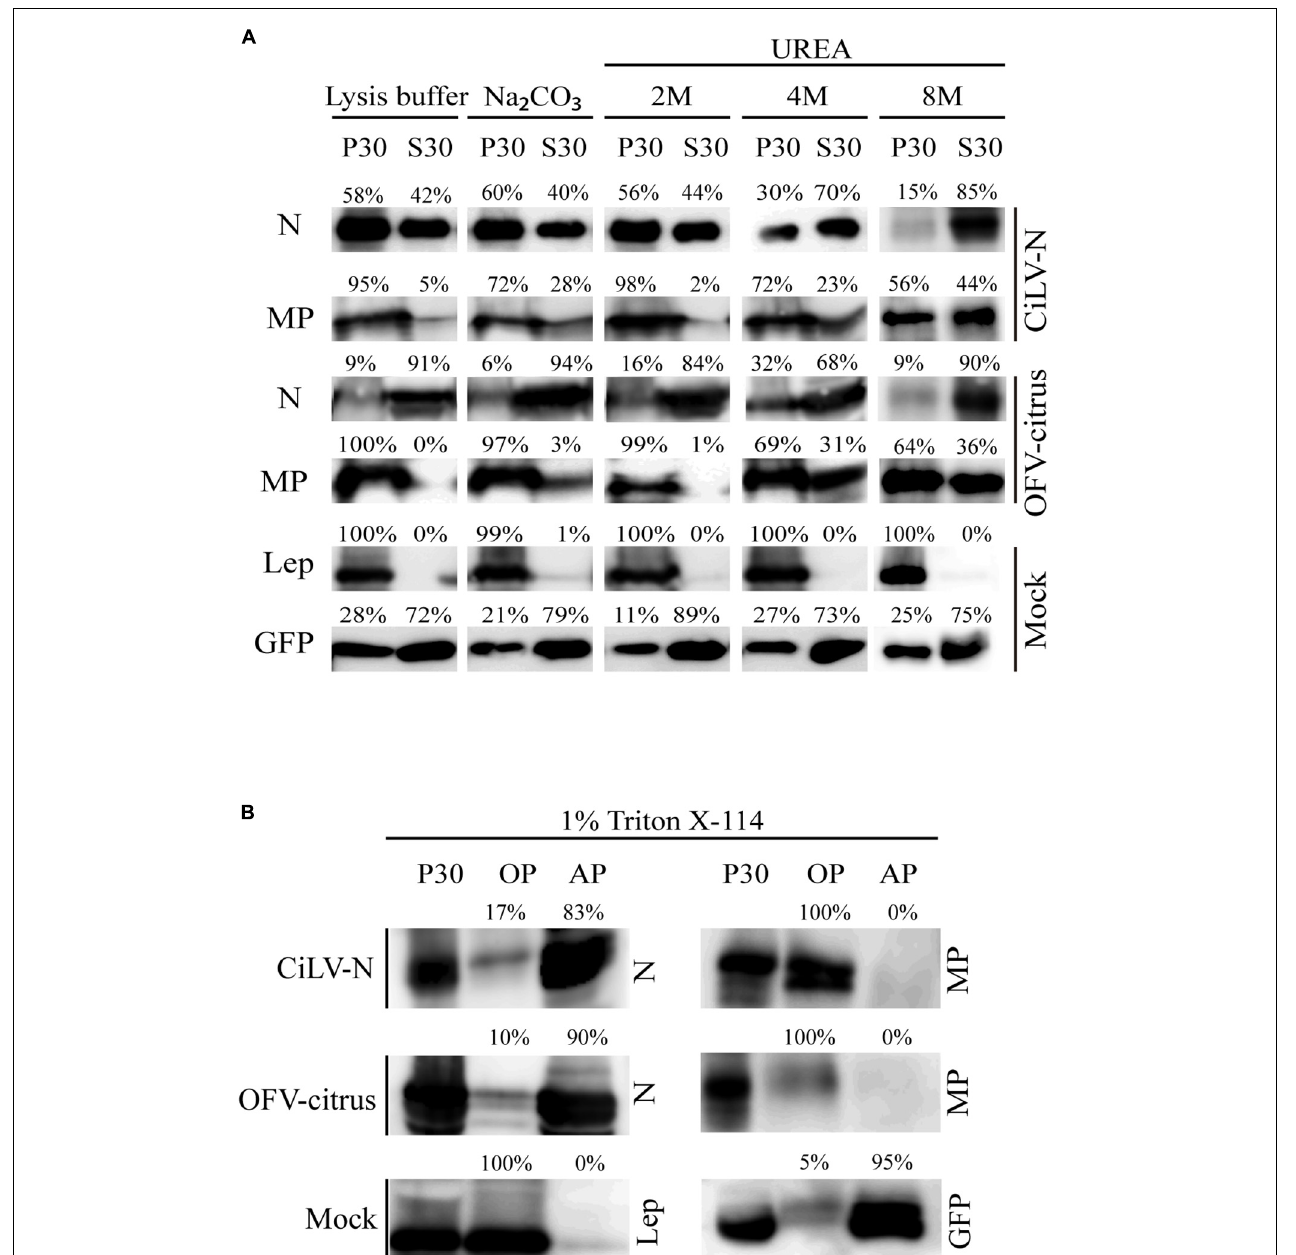
FIGURE 1 | Membrane association analysis of dichorhavirus MP and N proteins. (A) Separation into membranous and soluble fraction of CiLV-N and OFV-citrus MP and N proteins expressed in planta . Respective proteins targeted with HA were expressed in Nicotiana benthamiana leaves by agroinfiltration. As controls, we used leaf protein extracts containing unfused expressed eGFP (non-membrane) and the HA-tagged Lep (leader peptidase) (integral membrane) proteins, respectively. The supernatant from ultracentrifugation after membrane fractioning (S30), and comparable pellet (P30), untreated and alkaline or urea (2M, 4M, and 8M) treatments were analyzed by Western blot method using an anti-NtGFP antibody (Sigma-Aldrich, Steinheim, Germany) or anti-HA antibody (Thermo Fisher Scientific, Waltham, MA, United States). Relative quantification values are presented. (B) Triton X-114 partitioning assay of CiLV-N and OFV-citrus MPs and Ns. The P30 fractions subjected to treatment with Triton X-114 were separated in aqueous (AP) and organic (OP) phases. Equivalent amounts of fractions were analyzed by Western blot, and the same controls mentioned above were used.